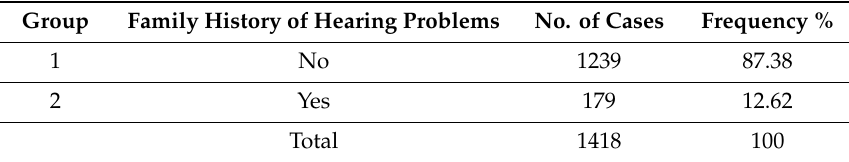
Table 3. Sample distribution based on family history of hearing problems. Source: Compiled by authors.